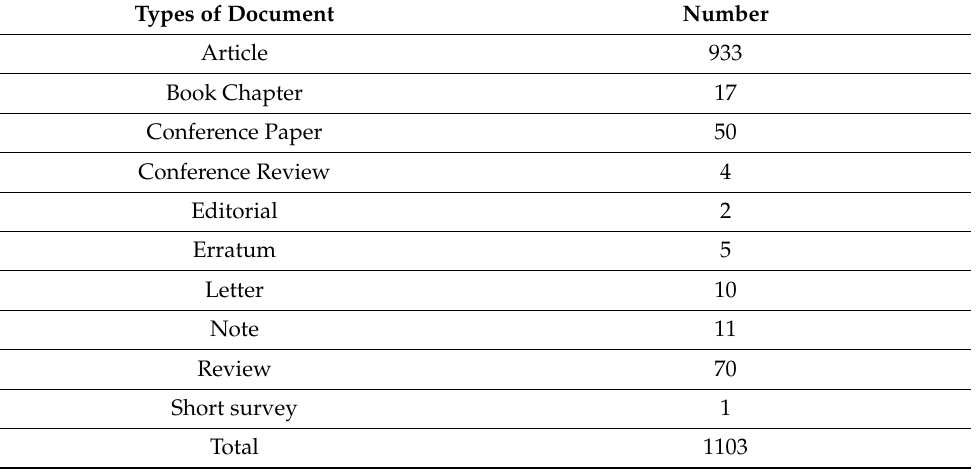
Table 1. Types of Documents in the